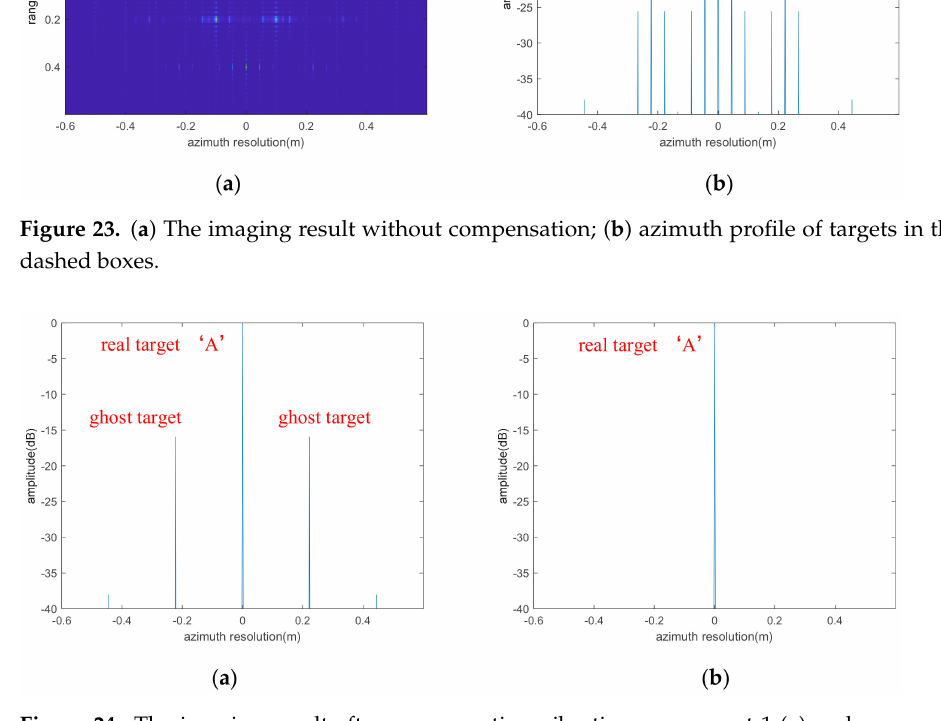
Figure 24. The imaging result after compensating vibration component 1 ( a ) and compensating vibration component 2 ( b ) using SoI 1 .